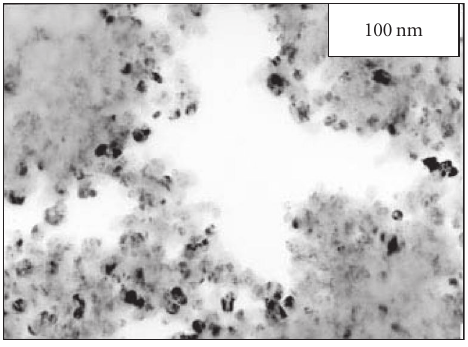
Figure 6: High-resolution transmission electron micrograph of the R70 TiO 2